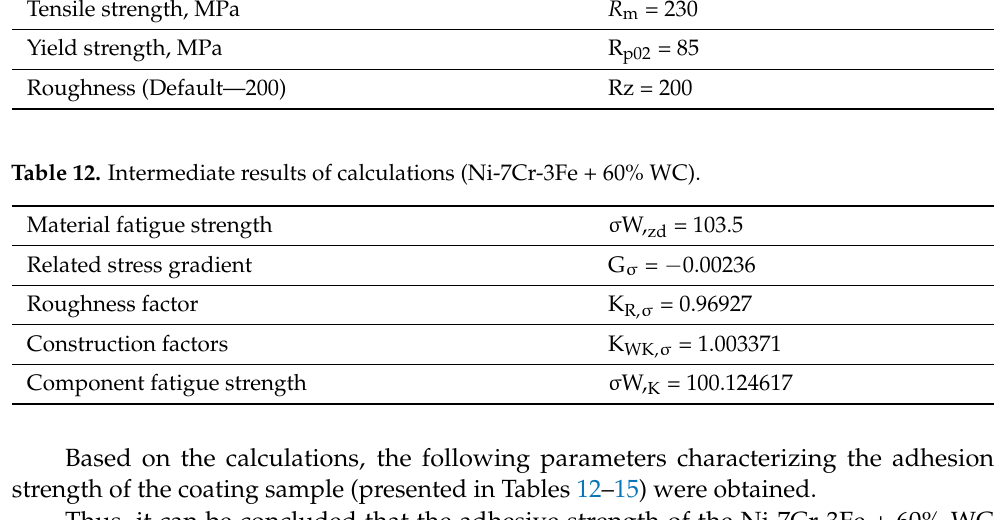
Figure 12. The results of the static analysis (spraying Cr 2 O 3 + polymer 23). ( A ) Stress concentration in the spraying surface layer; stress concentration on the surface of spraying; ( B ) stress concentration on the polymer concrete under spraying (the spraying layer is hidden).